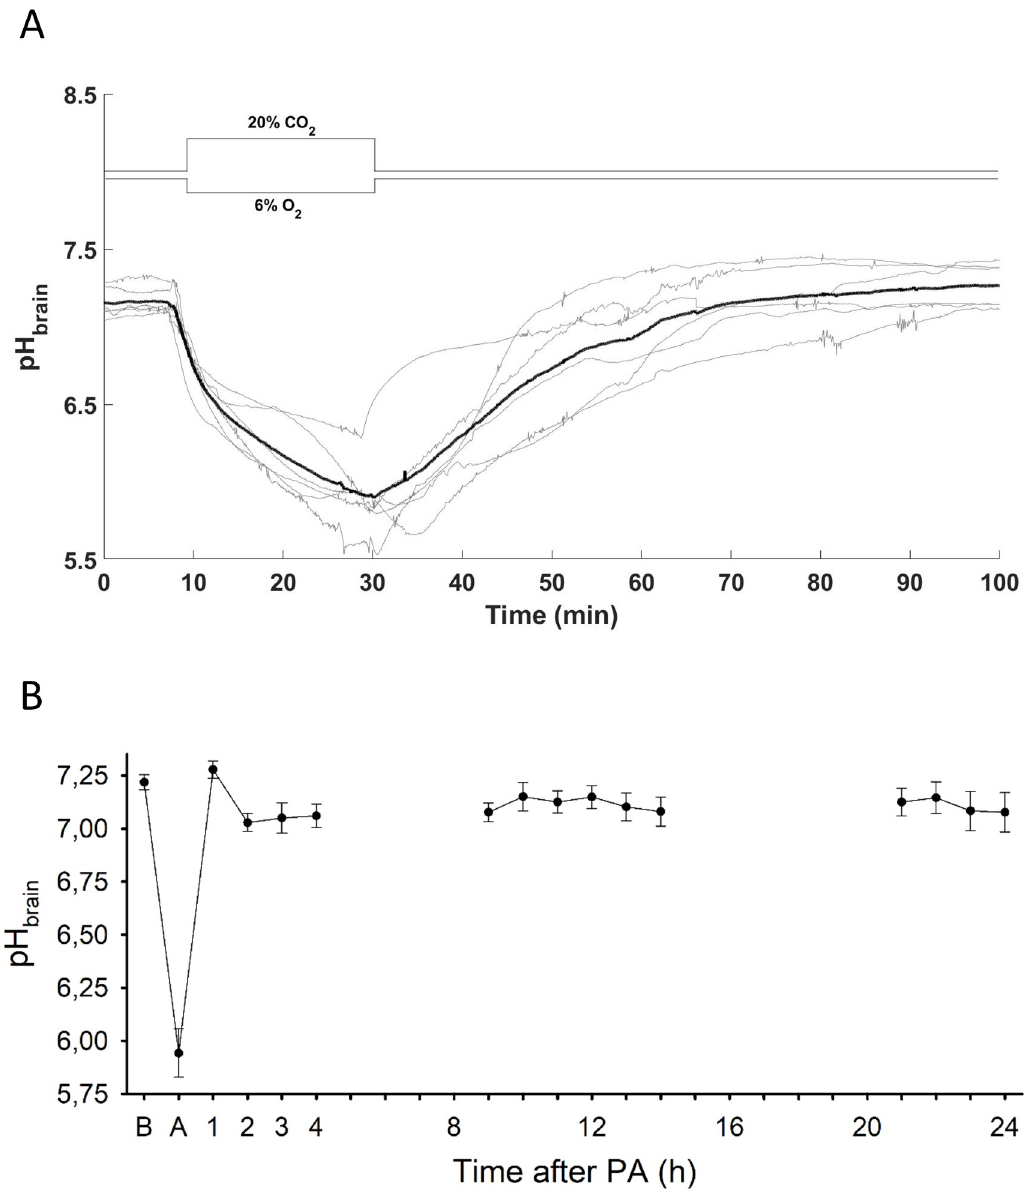
Fig 1. pH brain changes during PA and the reventilation period. (A) pH brain changes (grey lines–individual tracings, bold black line–mean) are plotted 10 min prior the onset asphyxia, during asphyxia, and the first hour of reventilation. pH brain fell progressively during asphyxia showing severe cerebrocortical acidosis, by the end of the insult the pH drop exceeded 1.0 pH unit virtually in all asphyxiated animals. Reventilation quickly restored pH brain to baseline levels. (B) pH brain alterations upon PA and over the 24-hour period after PA: after recovery from the PA-induced severe acidosis, no further significant pH brain alterations were detected at the selected time intervals (n = 6 at PA and between 1–4 hours; n = 8 between 8–14 hours and n = 3 between 20– 24 hours; respectively). B: baseline, A: at the end of 20 minute PA. Panel B data points are presented as mean ± SEM. � p < 0.05 vs . baseline.